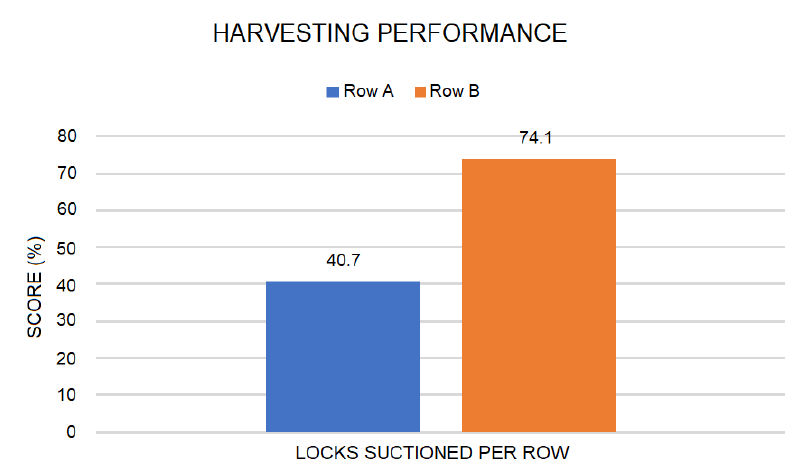
Figure 19. Field performance result of the mobile robot platform.